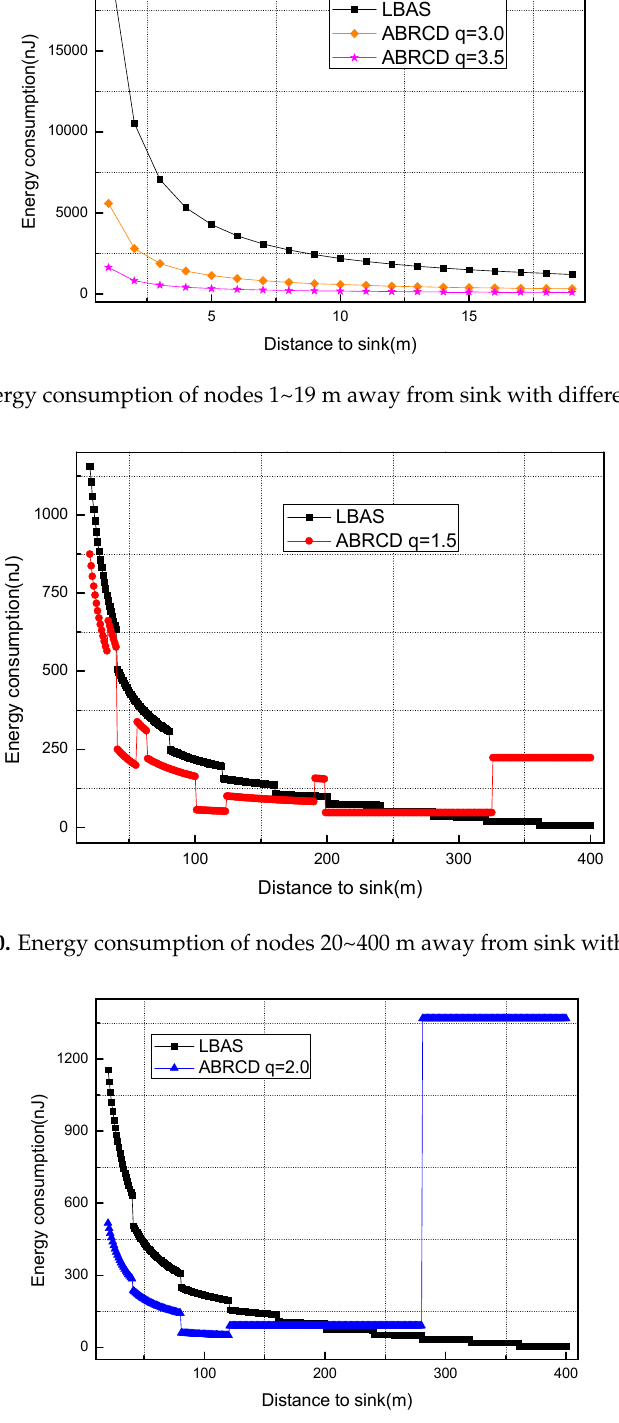
Figure 21. Energy consumption of nodes 20~400 m away from sink with q = 2.0.